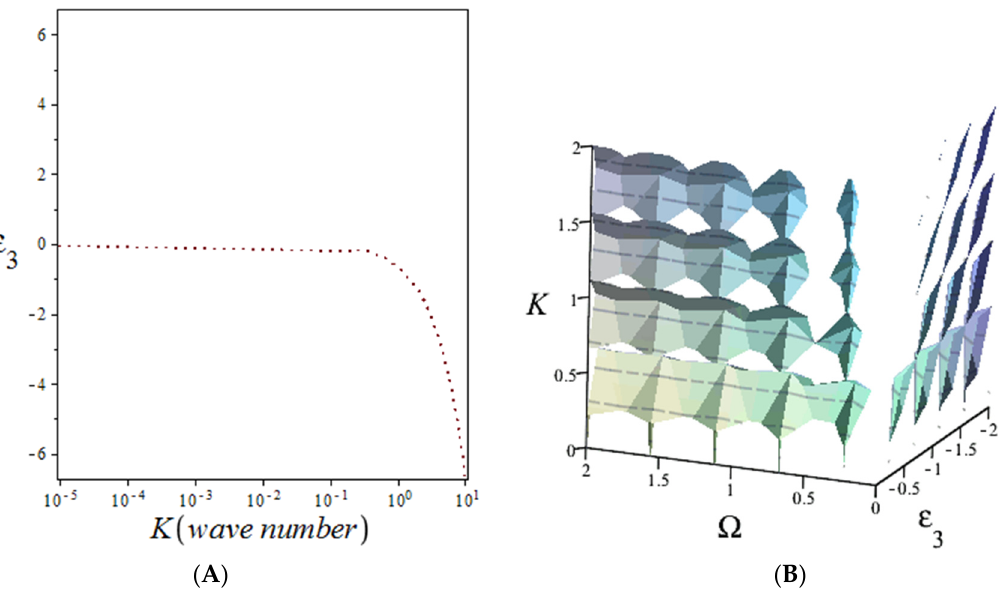
Figure 9. ( A ) Neutral curves for ε 3 versus the wave number b in the presence of rotation ( Ω = 10), and ( B ) three-dimensional view of the critical hypersurface shown in the wave number range 0 ≤ K ≤